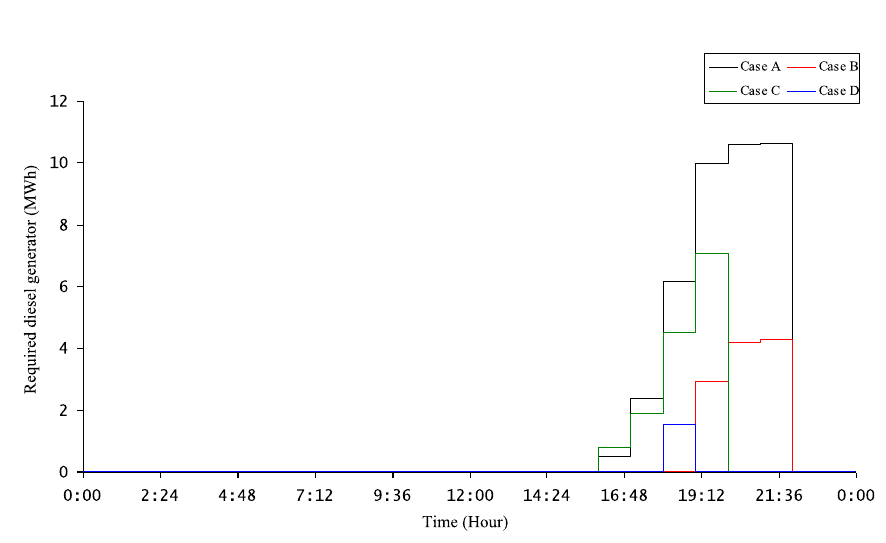
Fig. 12 Required capacities of diesel generator under four cases